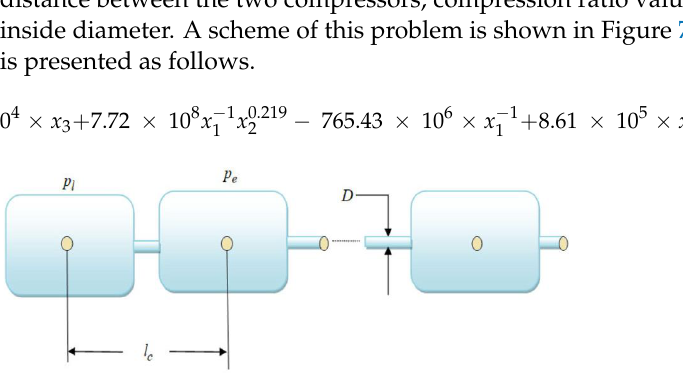
Figure 7. Gas transmission compressor design problem [64]. "Reprinted from Publication Reptile Search Algorithm (RSA): A nature-inspired meta-heuristic optimizer, vol. 191, 1 – 32, Copyright (2022), with permission from Elsevier." Table 12. Results of solving gas transmission compressor design problem.